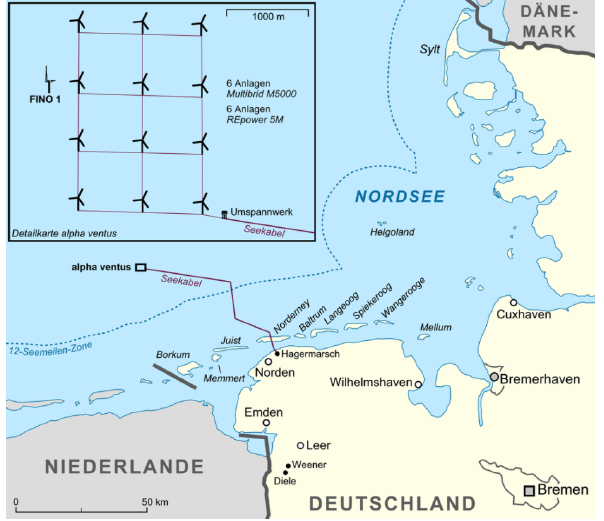
Figure 1. Overview of the region around the alpha ventus FINO1 tower. Figure (in German) from Wikimedia Commons, distributed under a CC BY-SA 3.0